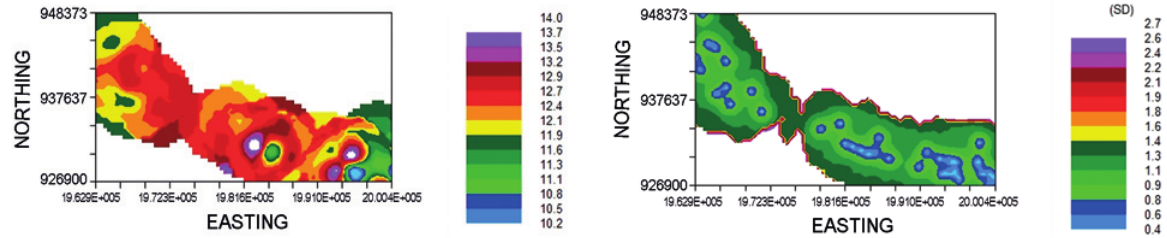
Fig. 4. Estimation of kriging method for porosity data Fig. 5. Distribution of error for porosity